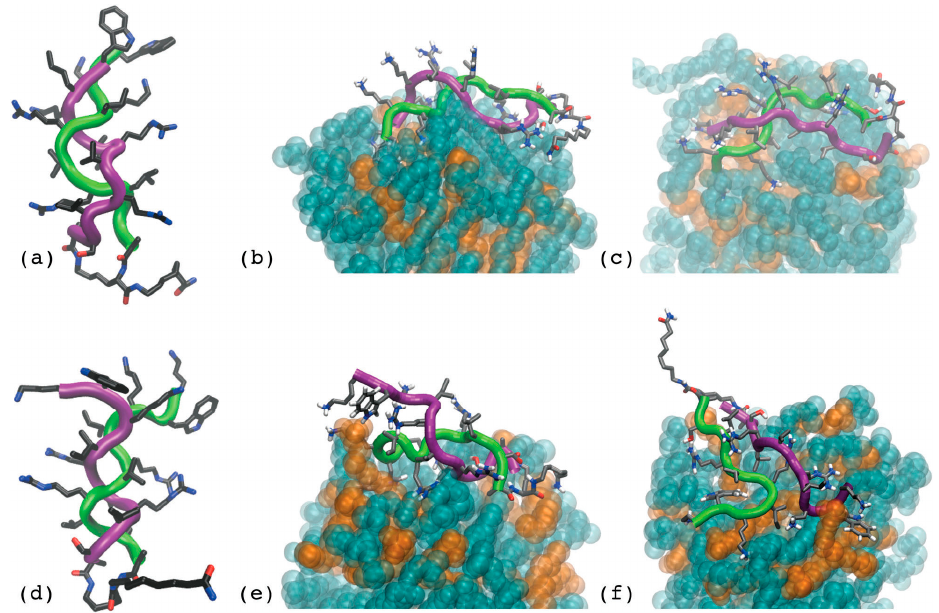
Figure 4. Structures obtained for SB056 ( a – c ) and ( d – f ) β SB056 in a dispersion of mixed dodecylphosphocholine (DPC)/sodium dodecyl sulphate (SDS) 3:1. These two detergents are synergistic and form mixed micelles, with the selected molar ratio being typically employed to mimic a bacterial plasma membrane [11]. First, a computer-simulated annealing was applied in a vacuum ( a , d ) with the distance restraints derived from experimental NOEs (cross peaks from Nuclear Overhauser Effect spectroscopy). Then, an equilibrium molecular dynamics (MD) simulation was run with the same restraints and in the presence of explicit water and detergent molecules. The last frame after 100 ns is shown in ( b , e ). Finally, a second 100-ns MD run was performed after releasing all restraints, and the last frame is shown in ( c , f ). The backbone of the α -and ε -branch is represented with a differently coloured trace, green and purple, respectively. The atoms of the detergents are represented with the corresponding van der Waals spheres. DPC and SDS are coloured in cyan and orange, respectively. From [30]. Reproduced with permission.